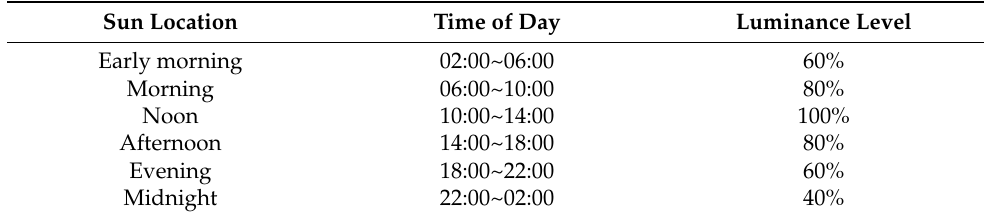
Table 1. Scheduling routine of TSCS.